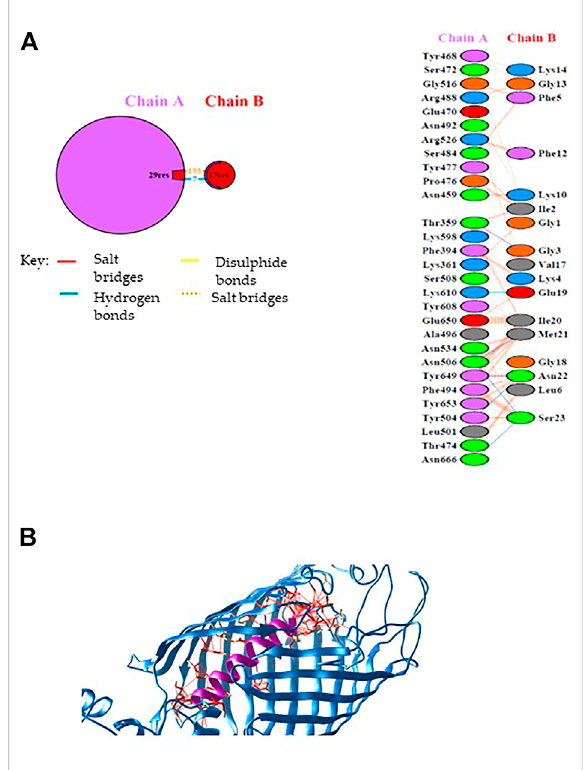
FIGURE 2 (A) Schematic representation of the identi fi ed interactions occurring at the protein-peptide interace. (B) Protein-peptide model obtained by docking calculations. The BamA protein is in blue while the Magainin-2 peptide is in purple. Interactions at the protein-peptide interface are shown by red lines. The image has been generated with UCSF CHIMERA software (De Beer et al.,